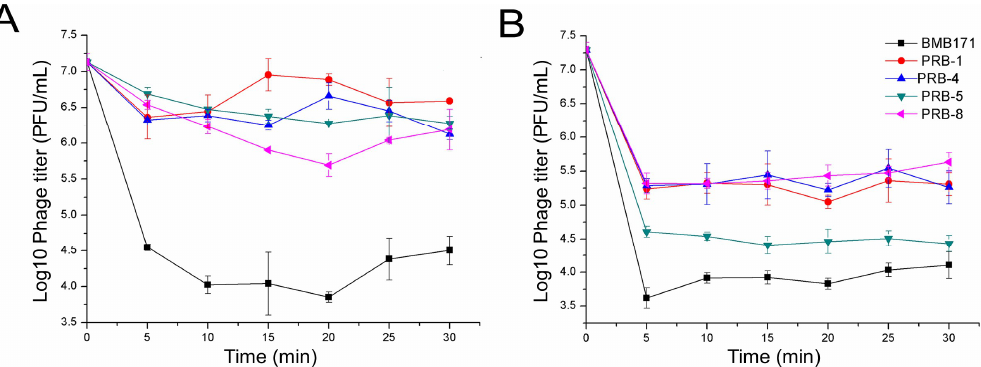
Figure 3. Absorption of phage vB_BthS_BMBphi ( A ) and vB_BthS_BMBphi-M1 ( B ) to strain BMB171 and four phage-resistant mutants.